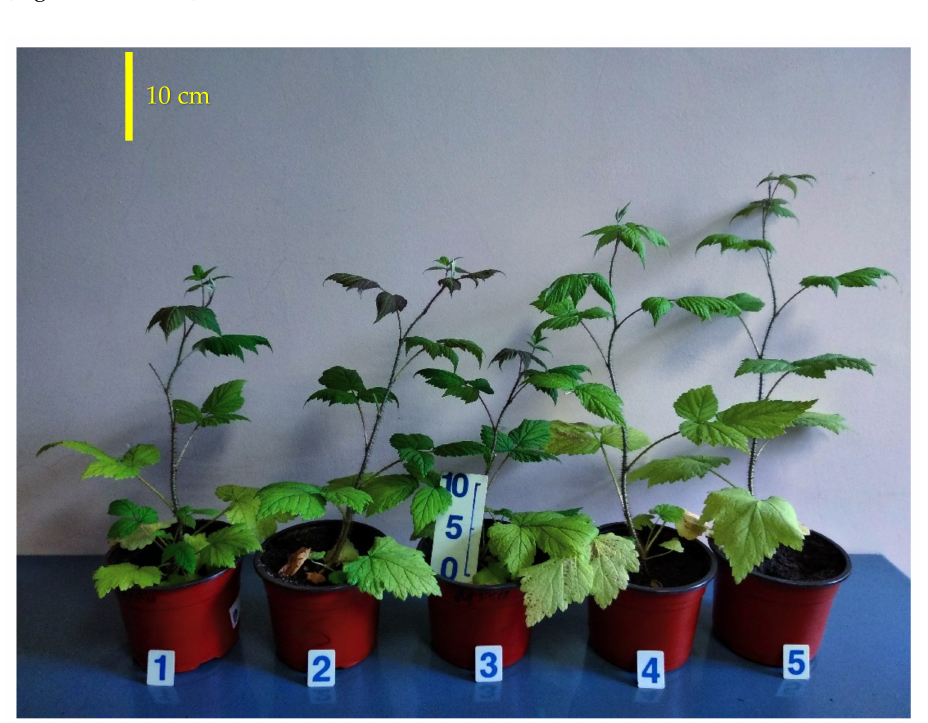
Figure 9. Raspberry plant growth responses to variation in red, green, and blue light distribution in the spectrum of optical radiation. Photo of representative plants, 45 days after transplanting. Treatment 1–3, 5—“blue” (B, ∆ λ 0.5 = 435 ÷ 458 nm, λ max = 447 nm), “green” (G, ∆ λ 0.5 = 500 ÷ 540